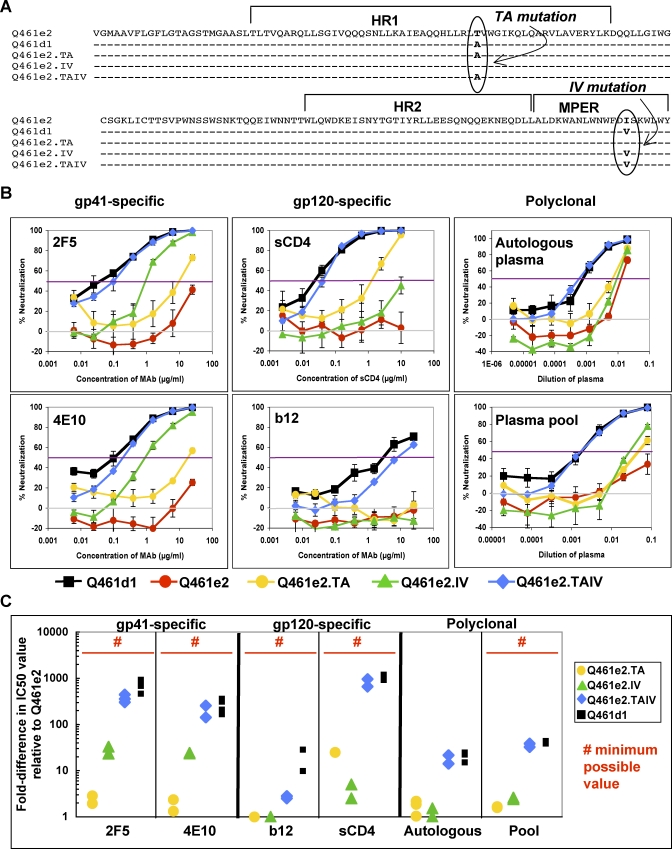
Sequence and Neutralization Profiles of Q461 Viral Variants(A) The predicted amino acid sequences of the portion of gp41 spanning from the fusion peptide to the MPER of the Q461 viral variants are shown. The locations of HR1, HR2, and MPER are indicated. The Q461e2 sequence is shown as a reference, and the locations of the TA and IV mutations within Q461d1 and the Q461e2 mutants are indicated in the oval and marked with an arrow. A dash indicates no change in the amino acid at that position.(B) Neutralization curves of pseudotyped viruses made with the Env variants described in (A). The y-axis represents the percentage of neutralization, the x-axis represents the concentration of MAb or dilution of plasma tested, as appropriate, and the color and symbol key for the different viral pseudotypes is shown at the bottom. The antibody or plasma sample used is indicated in the inset of the graph, and the global specificity above the charts. The purple line indicates 50% neutralization.(C) The fold-difference in the IC50 values for the Q461e2 mutants and the original neutralization-sensitive Q461d1 variant relative to Q461e2 are shown on log scale, and calculated as described in the Methods. Each point represents the value from a single experiment using an independent viral preparation, for two to four replicate experiments for each virus/antibody combination. Each individual experiment was performed in triplicate. When an IC50 value was not reached for the Q461e2 variant because of its neutralization resistance, the fold-difference for that antibody or plasma sample was calculated using the maximum concentration tested as the IC50 value for Q461e2, and thus reveals the minimum possible difference. A red # sign is marked in the graph above these minimum possible values. The color-coding of the different viruses is shown on the right and is the same as in (B). The specificity of the different antibodies is indicated above the graphs, with different specificities separated by bold lines.